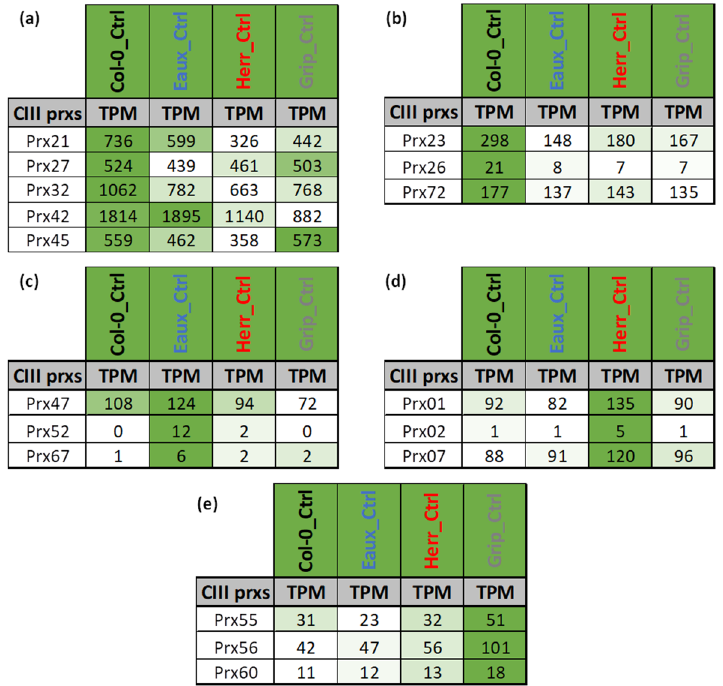
Figure 4. Tables of the averaged gene expression levels in transcripts per million (TPMs) in Col-0 and three Pyrenean populations (Eaux, Herr, and Grip) under control conditions (22 ◦ C): ( a ) Subset of CIII Prxs with high expression in all populations; ( b ) CIII Prxs with higher expression in Col-0, ( c ) in Eaux, ( d ) in Herr, and ( e ) in Grip. The color code scales the expression level of each gene across the samples (white <